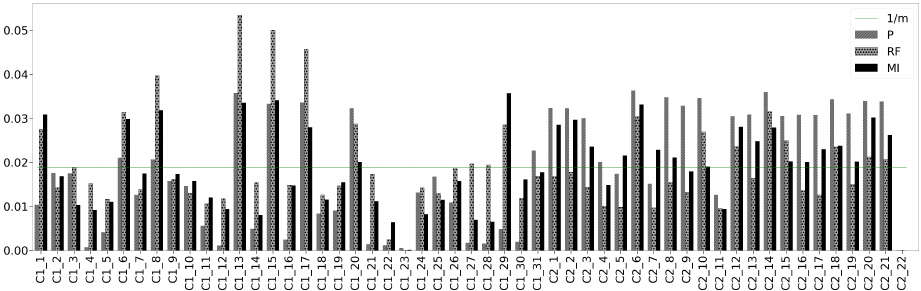
Figure 10. Feature weights estimated by each feature weighting method.